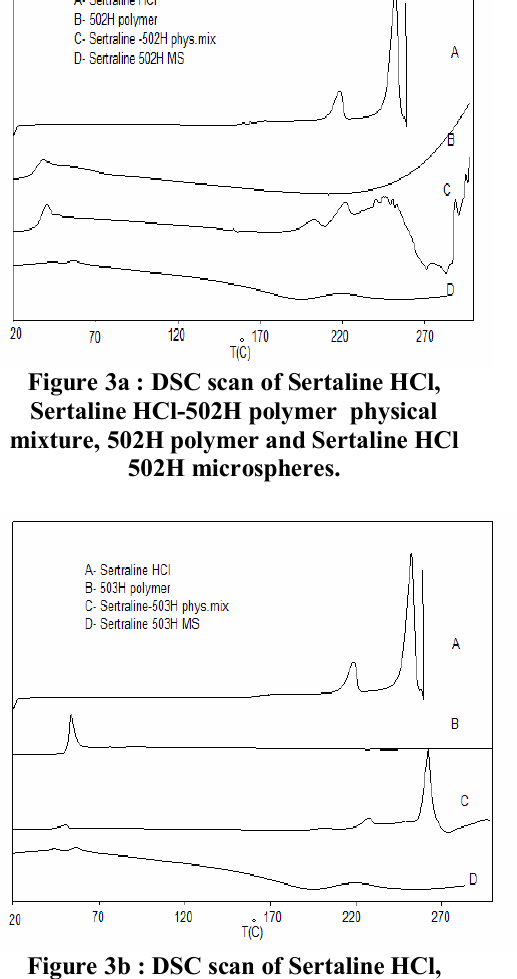
Figure 3b : DSC scan of Sertaline HCl, Sertaline HCl-503H polymer physical mixture, 503H polymer and Sertaline HCl 50